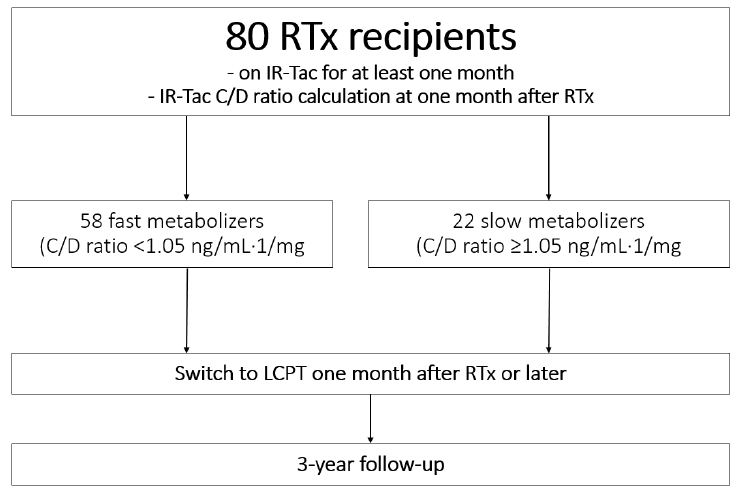
Figure 1. Study design and patient enrolment. A total of 80 renal transplant recipients met the inclusion criteria. RTx recipients were defined as fast and slow Tac metabolizers one month after transplantation. All patients were switched to LCPT and observed in a 3-year follow-up. Abbreviations: RTx, renal transplantation; IR-Tac, immediate-release tacrolimus; C/D ratio, concentration-to- dose ratio.